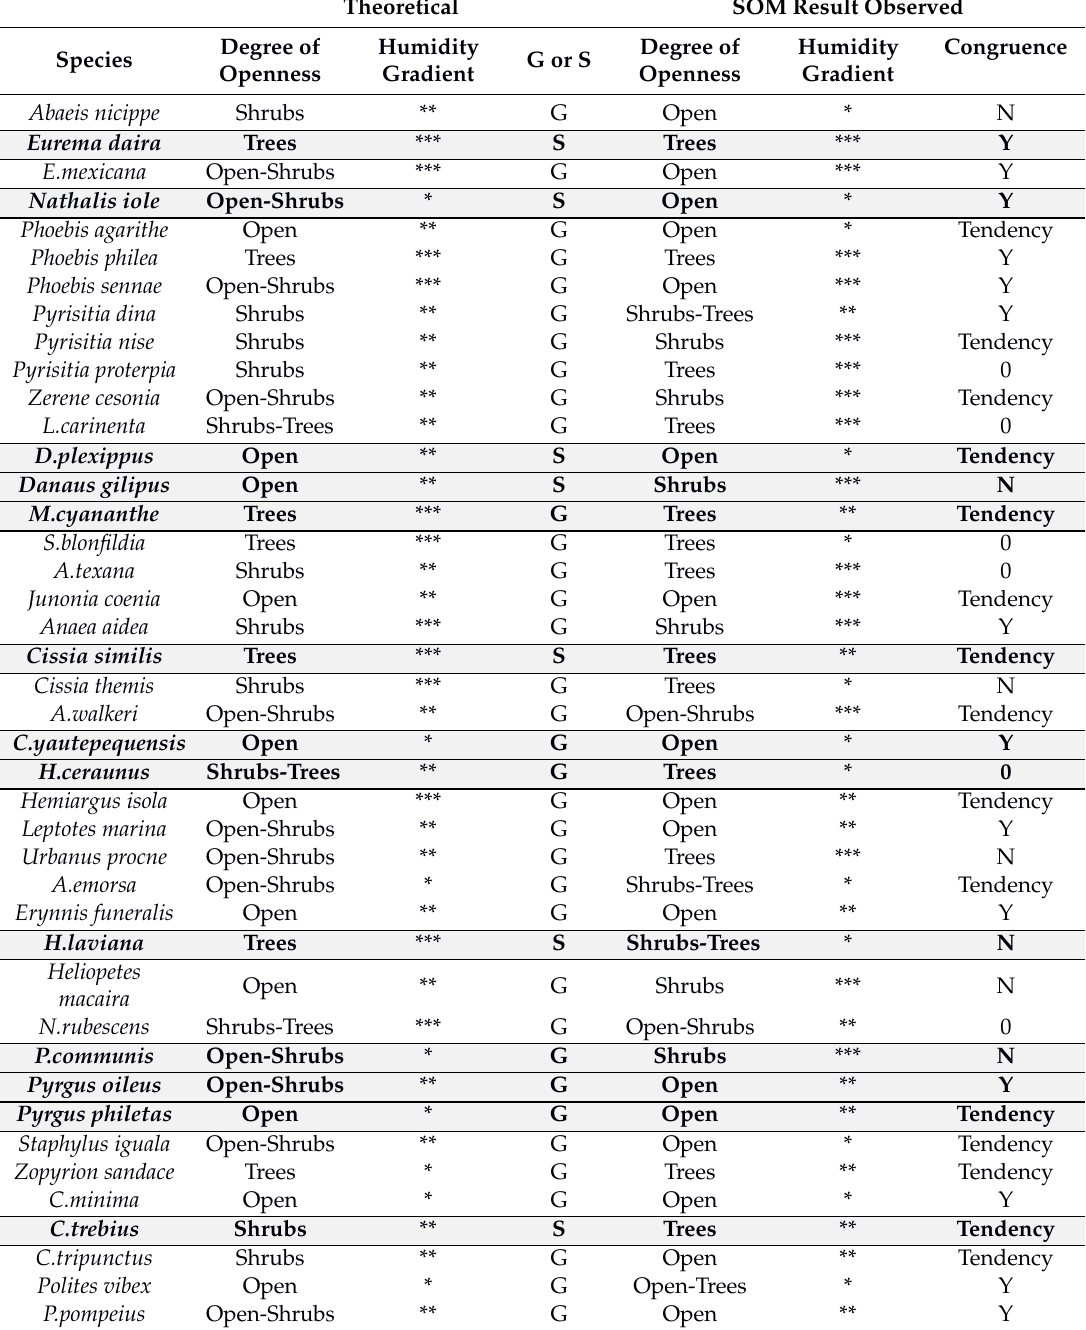
Table A3. Theoretical versus observed distributions (SOM analysis) of the 42 species sampled in the dry season. “G” is generalist species and “S” is specialist species. Evaluation of the congruence: Y: 14 / 42 species (33.3%); N: 7 / 42 species (16.7%); 0: compatible but not positive or negative, Tendency: congruence not at 100%. Bold species are considered bioindicators. Note: some generic names were abbreviated to fit the